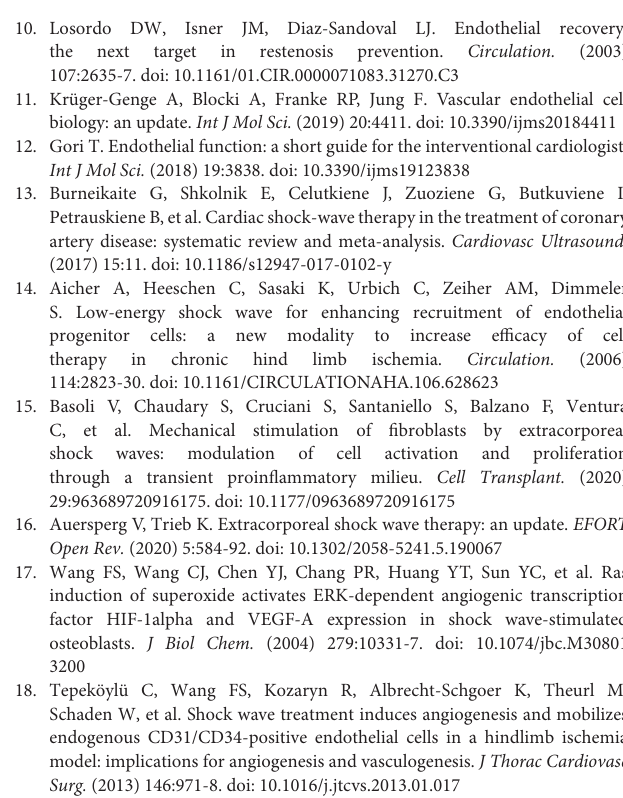
Supplementary Figure 1 | Schematic diagram of segmental measurement. P, proximal segment; M, middle segment; D, distal segment. Supplementary Figure 2 | Representative histological images of vein segments parallel to the treated arteries at 0, 5, and 28 days postoperatively. Magnified images of rectangular areas are shown below each low-magnification image. IVL, intravascular lithotripsy; POBA, plain old balloon angioplasty. Supplementary Table 1 | Semi-quantitative scoring criteria of pathologic changes of